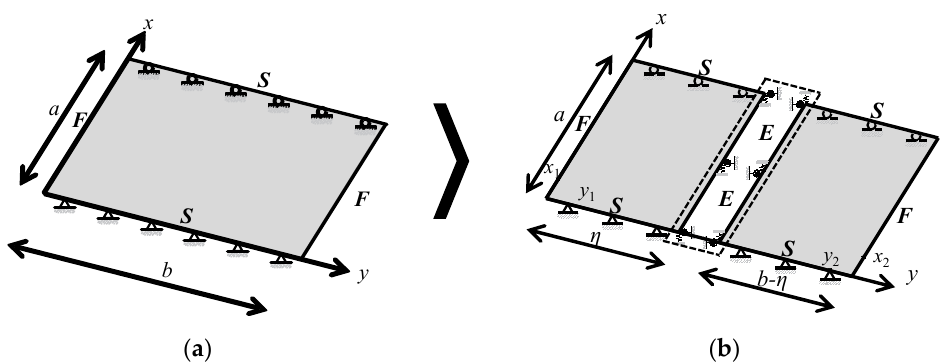
Figure 6. Equivalent orthotropic plate: ( a ) free boundary; ( b ) elastically supported boundary. S : simple supported edge; F : free edge; E : elastically supported edge. Based on Kirchhoff thin plate theory, the equivalent elastic boundary condition at the hinge joint position y η= and the free boundary condition at the hinge joint position 0 y = are considered for “plate L” without losing generality, as follows.